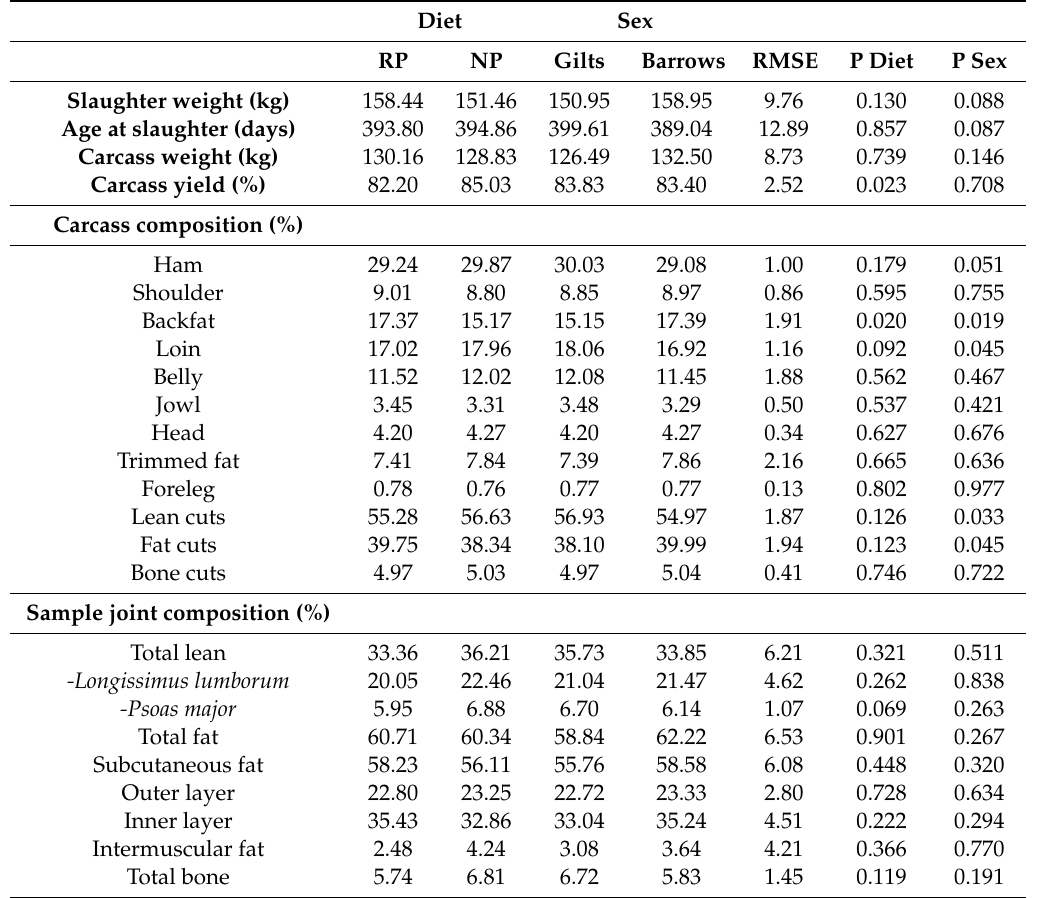
Table 3. E ff ects of protein restriction on Cinta Senese slaughtering traits: postmortem performances on carcass, main cuts and Longissimus l. muscle